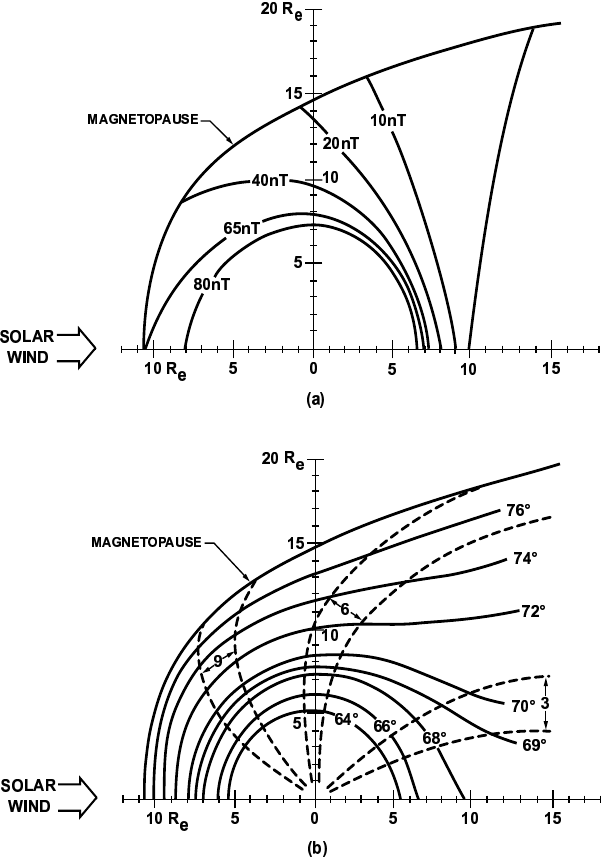
Fig. 14. Average magnetic field characteristics projected onto the geomagnetic equatorial plane: (a) contours of constant magnetic field intensity; (b) contours in the equatorial plane of the latitude and local time of the point of intersection of a field line with the Earth’s surface. An energetic particle with an equatorial pitch-angle of 90 ◦ will follow the constant B -field contours of (a), whereas a particle with a small equatorial pitch-angle mirroring just above the atmosphere of the Earth will essentially follow the solid contours in (b) as each of these particle types drift in azimuth (from Lyons and Williams,